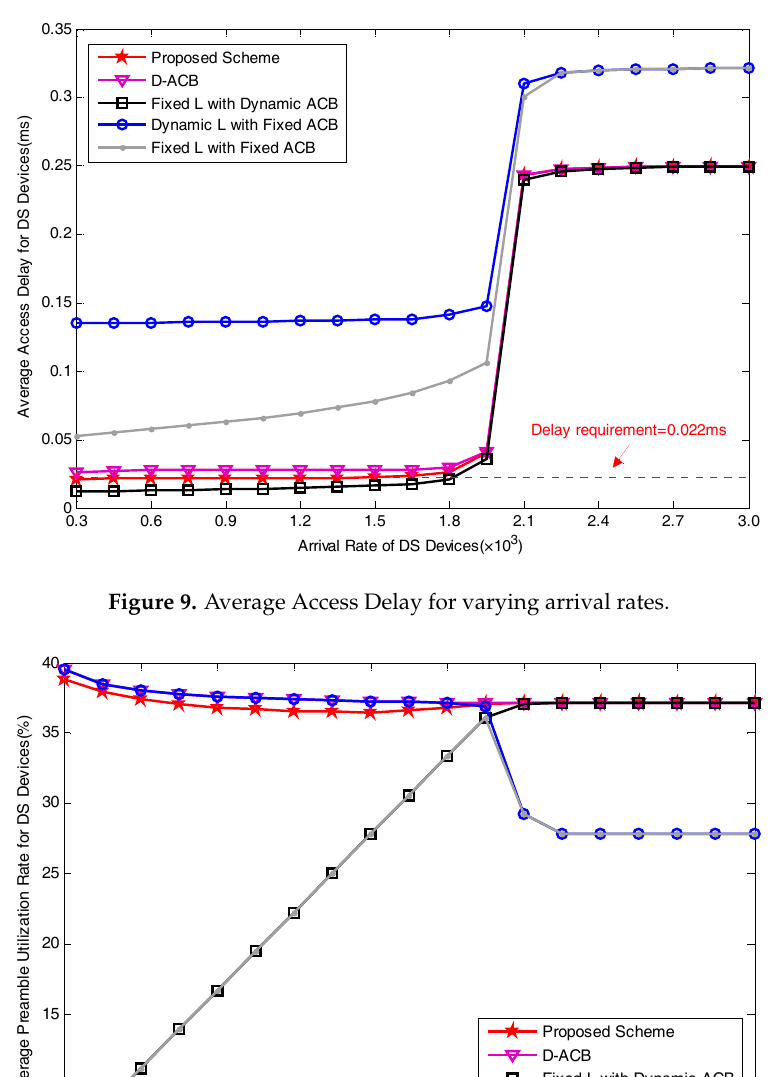
Figure 11. Average Number of Preambles for Pool 2 for varying arrival rates. 6. Conclusions In this paper, we have proposed a novel random access scheme which is applicable to the scenario where delay-sensitive and delay-tolerant services coexist. Our novelty lies in the full consideration of the characteristics of delay-sensitive devices. For the high latency tolerance of delay- tolerant devices, we put this kind of equipment on a lower priority, and discuss the optimization problem from the perspective of delay-sensitive devices. By dynamically adjusting the ACB factor and the number of available preambles for delay-sensitive services, our proposed scheme can realize good performance in satisfying the QoS requirement as well as increasing the utilization rate of the random access resources allocated to them. High utilization rate ensures the resource efficiency therefore more resources can be leaved for delay-tolerant ones. Our proposed scheme can provide a